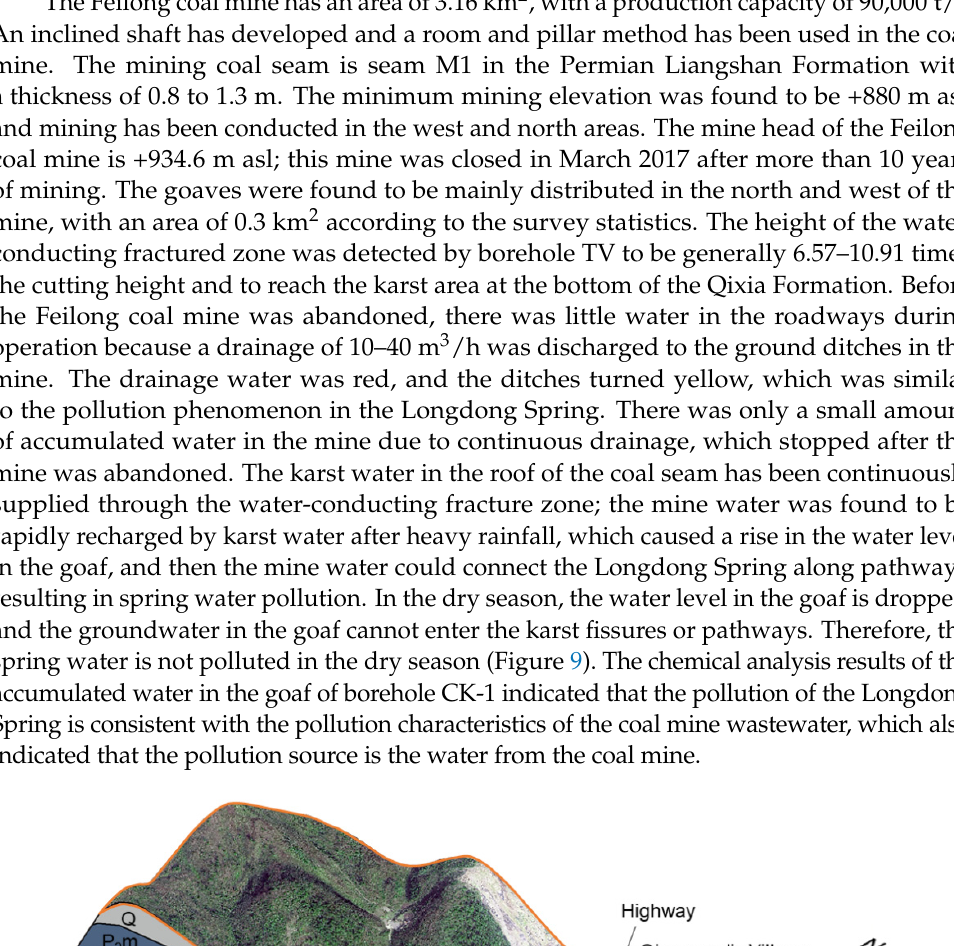
polluted by the mine water from the Xiaguyan coal mine, the Gebaochong Spring group would be polluted first. However, the Gebaochong Spring Group has never been polluted in recent years. Even after the Longdong Spring was polluted, the Gebaochong Spring group remained clear. In addition, the Dafengdong Karst Gully located between the Fei- long and Xiaguyan coal mines is the erosion base level in the region (Figure 1a). Ground- water in both the northern part of the Feilong coal mine and the southern part of the Xiaguyan coal mine was found to be discharged into the Dafengdong Karst Gully. Then, the water merges into the Dafengdong Karst Gully and runs off from the southwest to the northeast towards Dafengdong Town, which indicates that the Longdong Spring is less likely to be polluted by drainage from the Xiaguyan coal mine. 3.4. Groundwater Accumulation in Abandoned Mine Goaves Figure 10 shows three-dimensional result according to transient electromagnetic sur- vey, where blue and red represent relatively low and high resistance areas, respectively. The suspected goaves are distributed in the west and northwest of the study area. The goaves of the Feilong coal mine are in the west of this area (with a relatively higher eleva- tion), which are also characterized by borehole drilling and investigation. Meanwhile, the northwest area houses the goaves of the Xiaguyan coal mine. The suspected groundwater accumulation zones in the goaves are in the north and center of the study area with a relatively low terrain, which made it even more susceptible to karst water recharge and